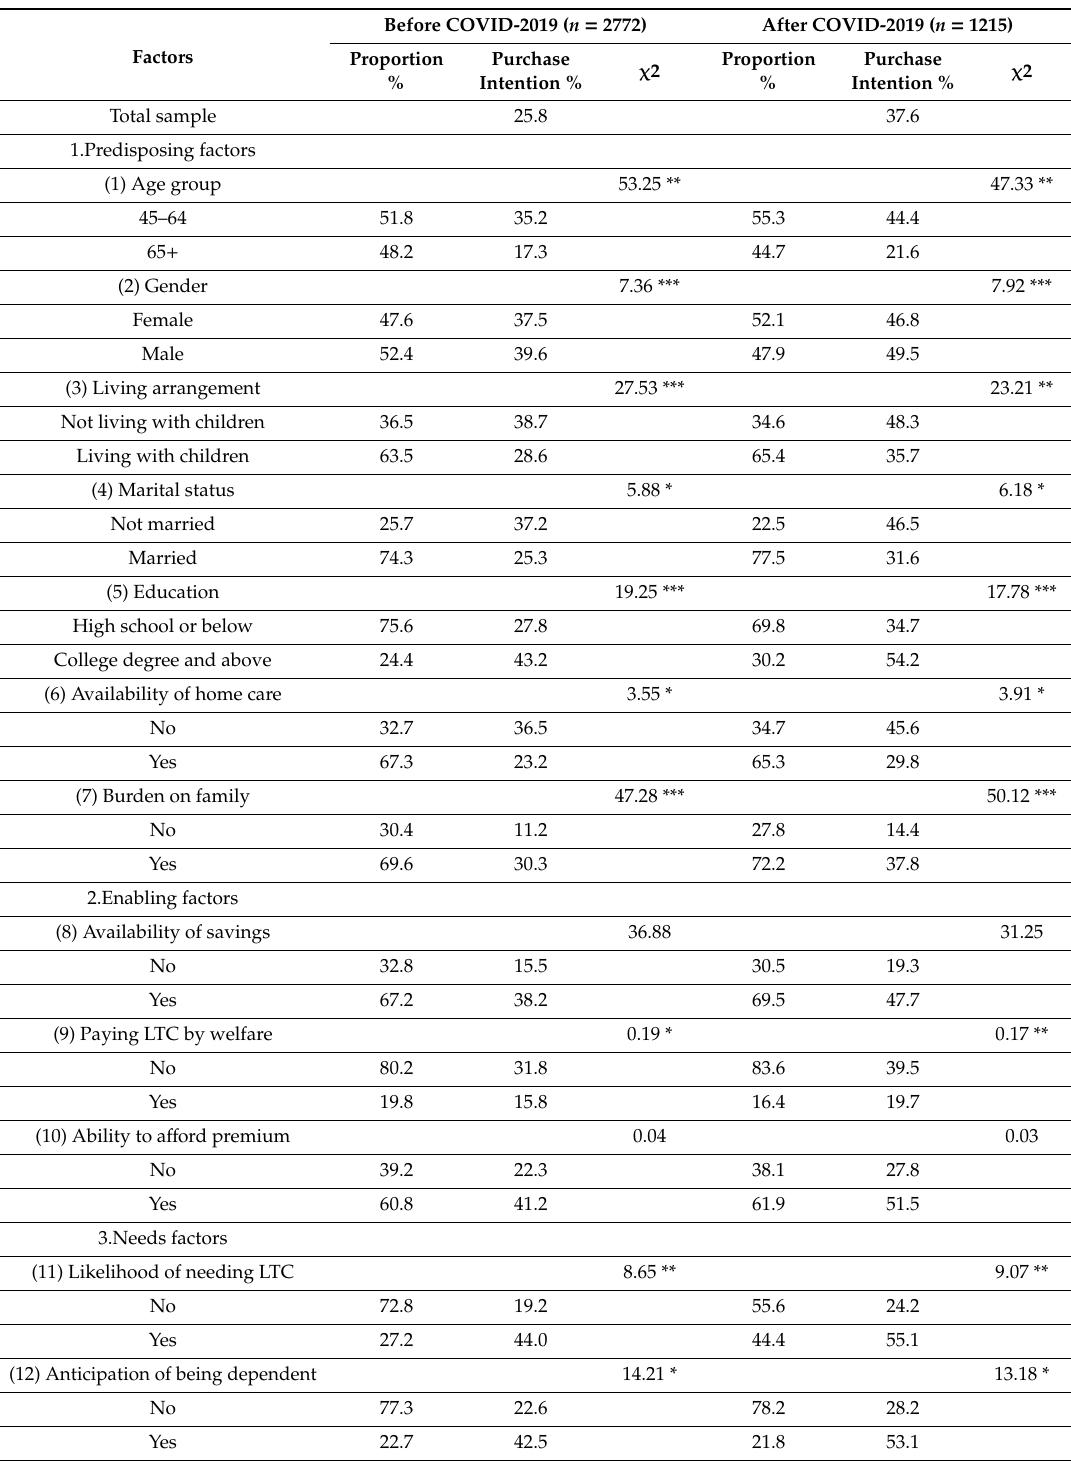
Table 1. Comparison of bivariate analyses of the e ff ects of predisposing, enabling and needs factors on the purchase intention of commercial long-term care insurance (LTCI) in the period of before and after